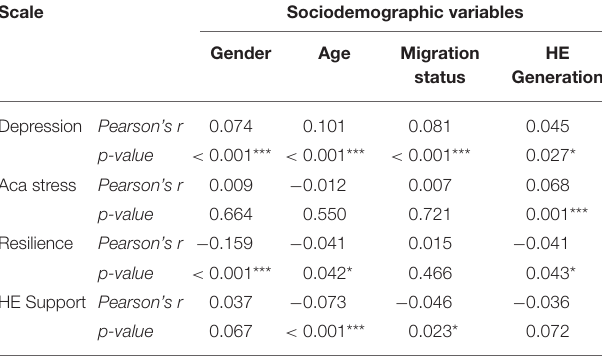
TABLE A2 | Covariate